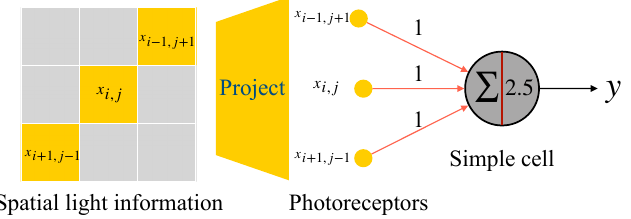
Figure 7. Realization of a 45 ◦ -selective simple cell based on MP